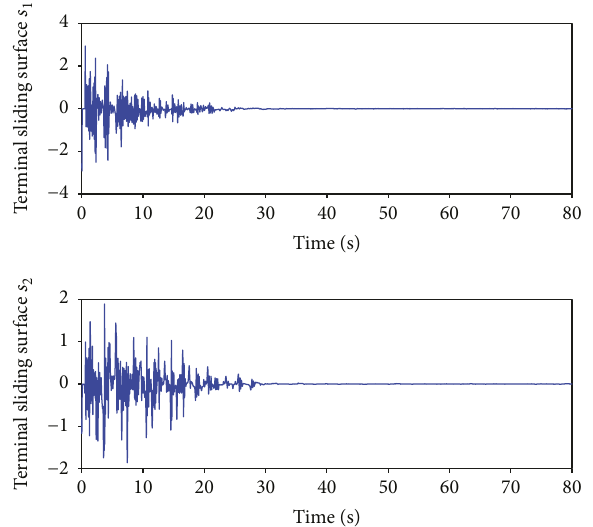
Figure 9: Adaption of damping coe ffi cients of the microgyroscope.